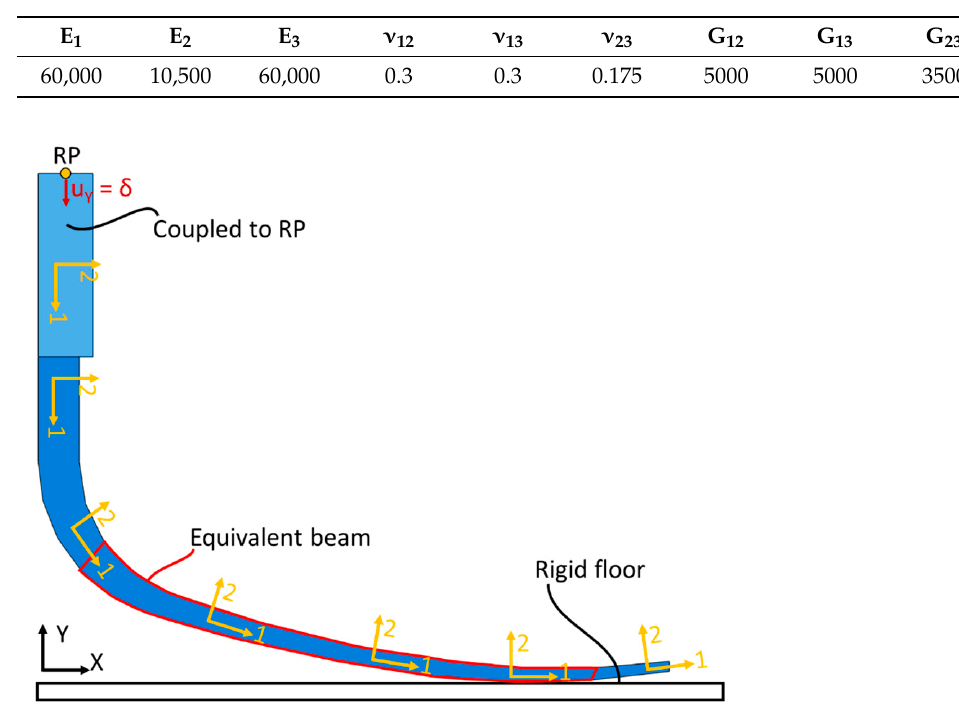
Figure 7. ( a ) The Össur VARI–FLEX TM design taken from [32] and ( b ) the inspired laminated component.